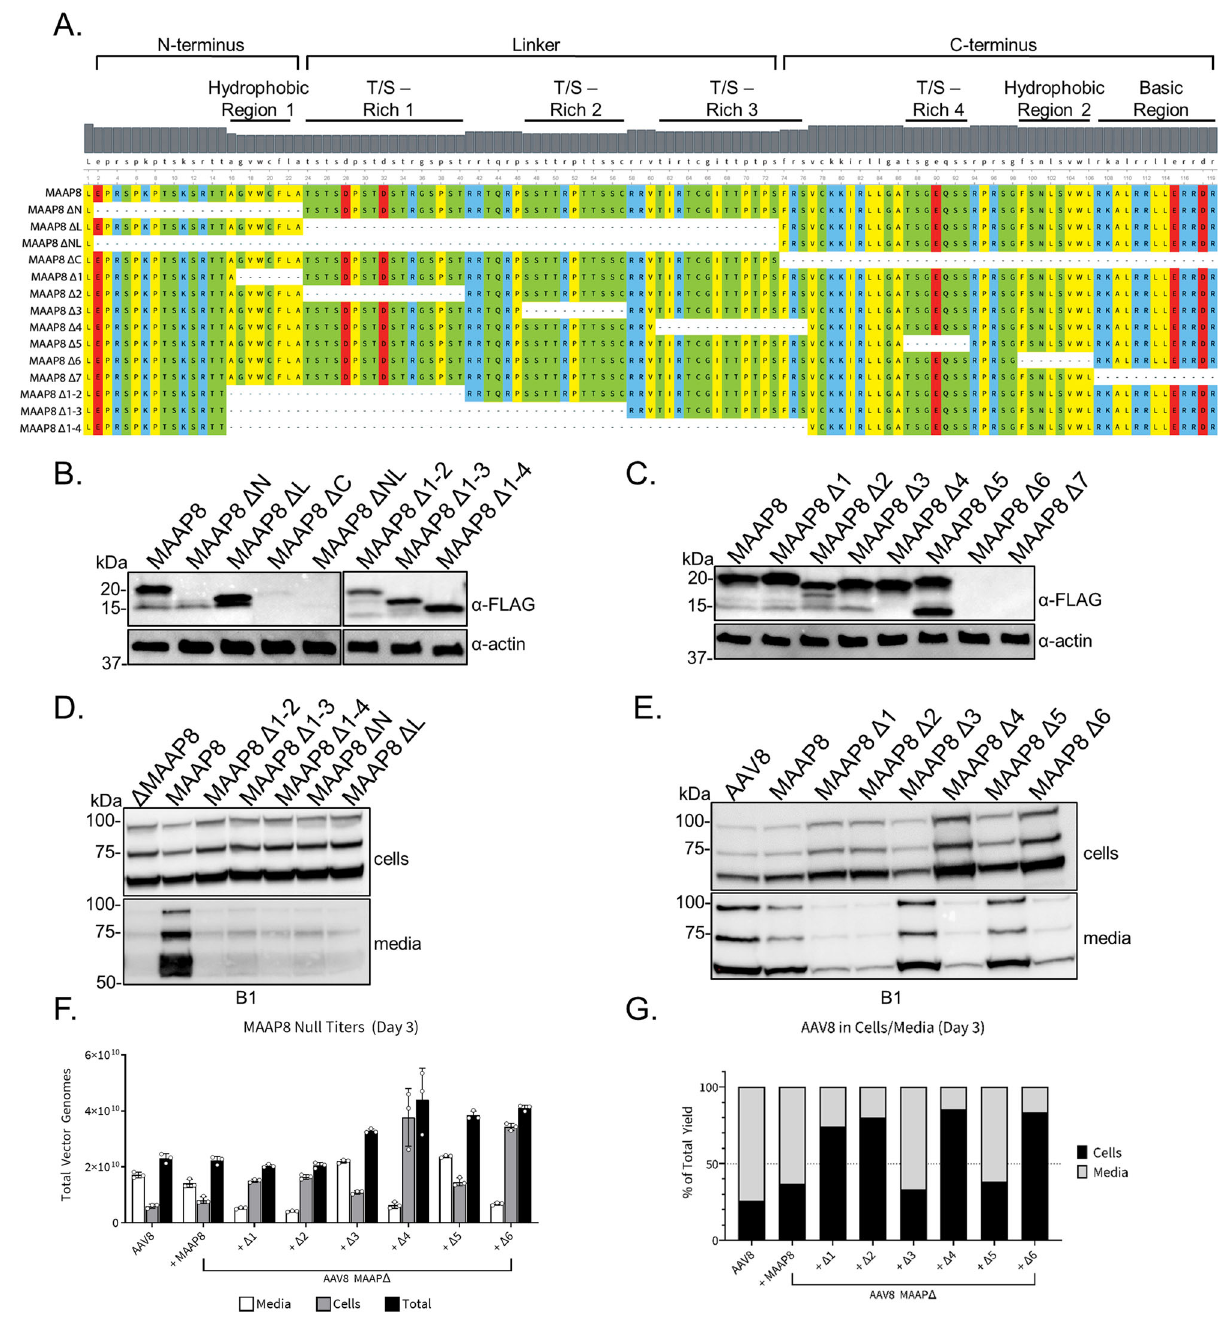
Fig. 3 Structure – function analysis of MAAP8 reveals regions critical for expression and AAV secretion. A Schematic of different MAAP mutants. All MAAP mutants have a 3X-FLAG tag at the C terminus. B , C Anti-FLAG immunoblot of whole-cell extracts prepared from HEK293 cells expressing indicated MAAP8-3X-FLAG tagged constructs. Anti-actin immunoblot served as loading control. Immunoblots are representative images of two independent experiments. D , E Recombinant MAAP8 Δ vectors complemented in trans with various truncated MAAP8-3X-FLAG plasmids were analyzed from the media and pellet of HEK293 producing cells at day 3 post transfection. Capsid proteins were analyzed by SDS-PAGE under reducing conditions and probed with a capsid (B1)-speci fi c antibody. Immunoblots are representative images of two independent experiments. Total vector genomes ( F ) and the proportion of vector found in the media and cells ( G ) 3 days post transfection. Each bar is a representation of three experiments that are biological replicates. Data are presented as mean values±